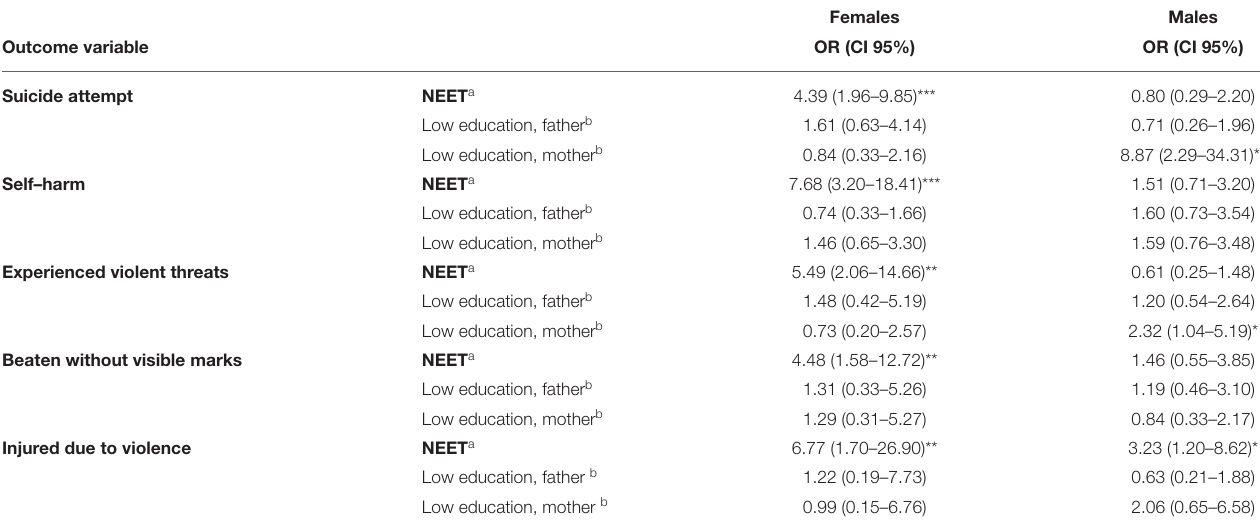
TABLE 2 | Associations between NEET status and outcome variables, compared to high-school students (reference group), stratified by sex, and after adjusting for parental